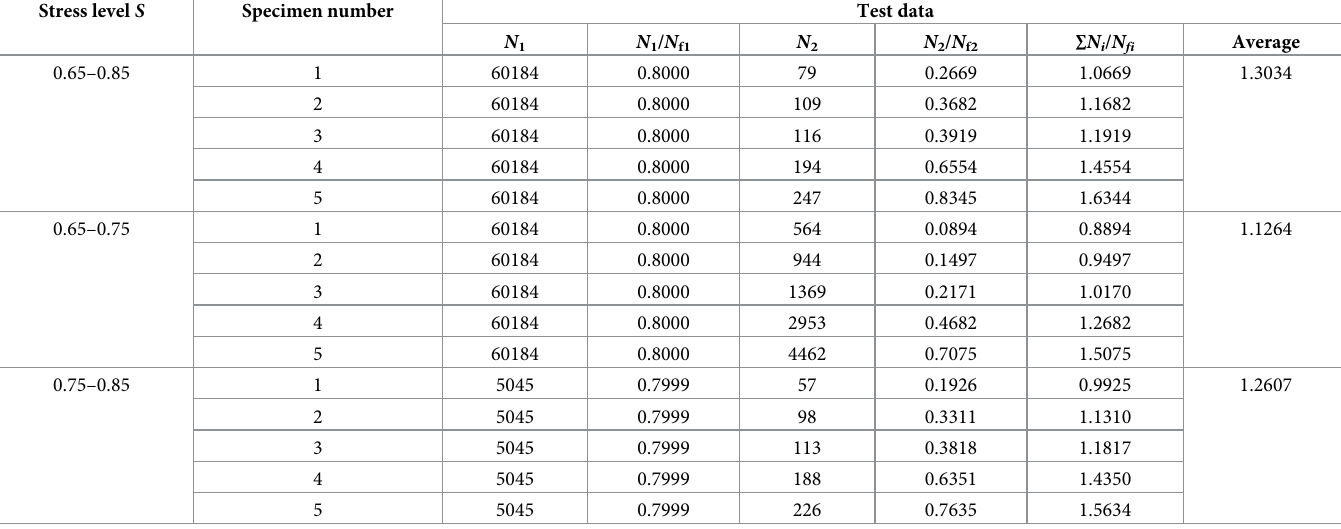
Table 14. Test results of flexural fatigue damage of concrete under two-stage loading (low-high order). Stress level